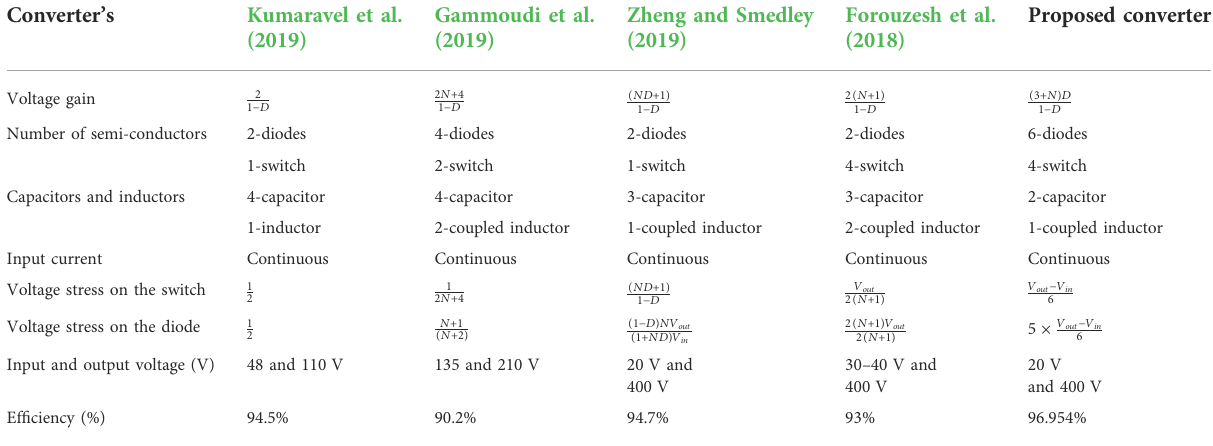
TABLE 2 Performance of different topologies and the proposed